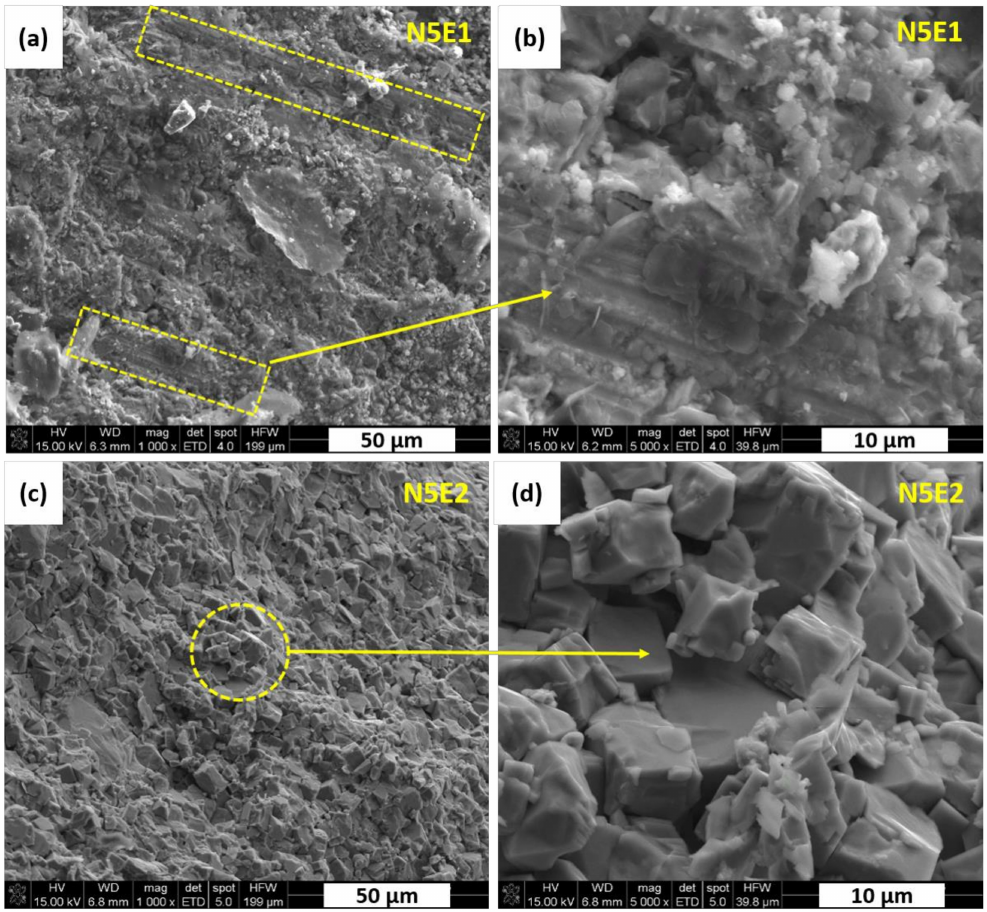
Figure 6. KNN polycrystals fractures: ( a , b ) N5E1 sample ( c , d ) N5E2 sample; all images recoded in SE